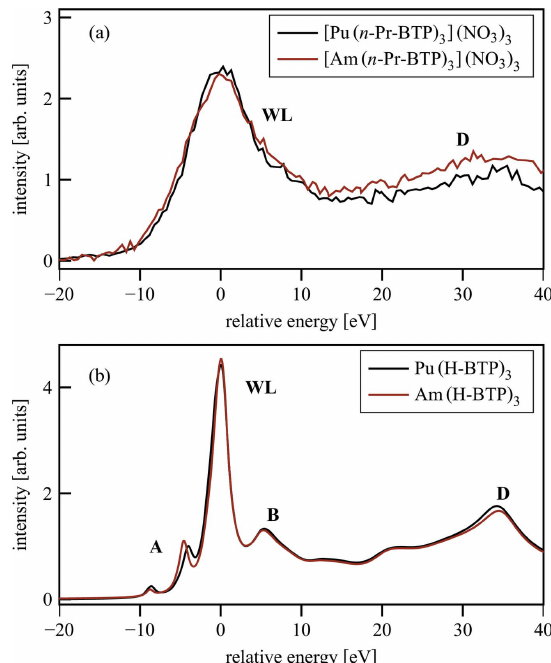
Figure 14 Experimental spectra of [Pu( n -Pr-BTP) 3 ](NO 3 ) 3 and [Am( n -Pr- BTP) 3 ](NO 3 ) 3 ( a ) and spectra calculated with FDMNES of Pu(H- BTP) 3 and Am(H-BTP) 3 ( b ).